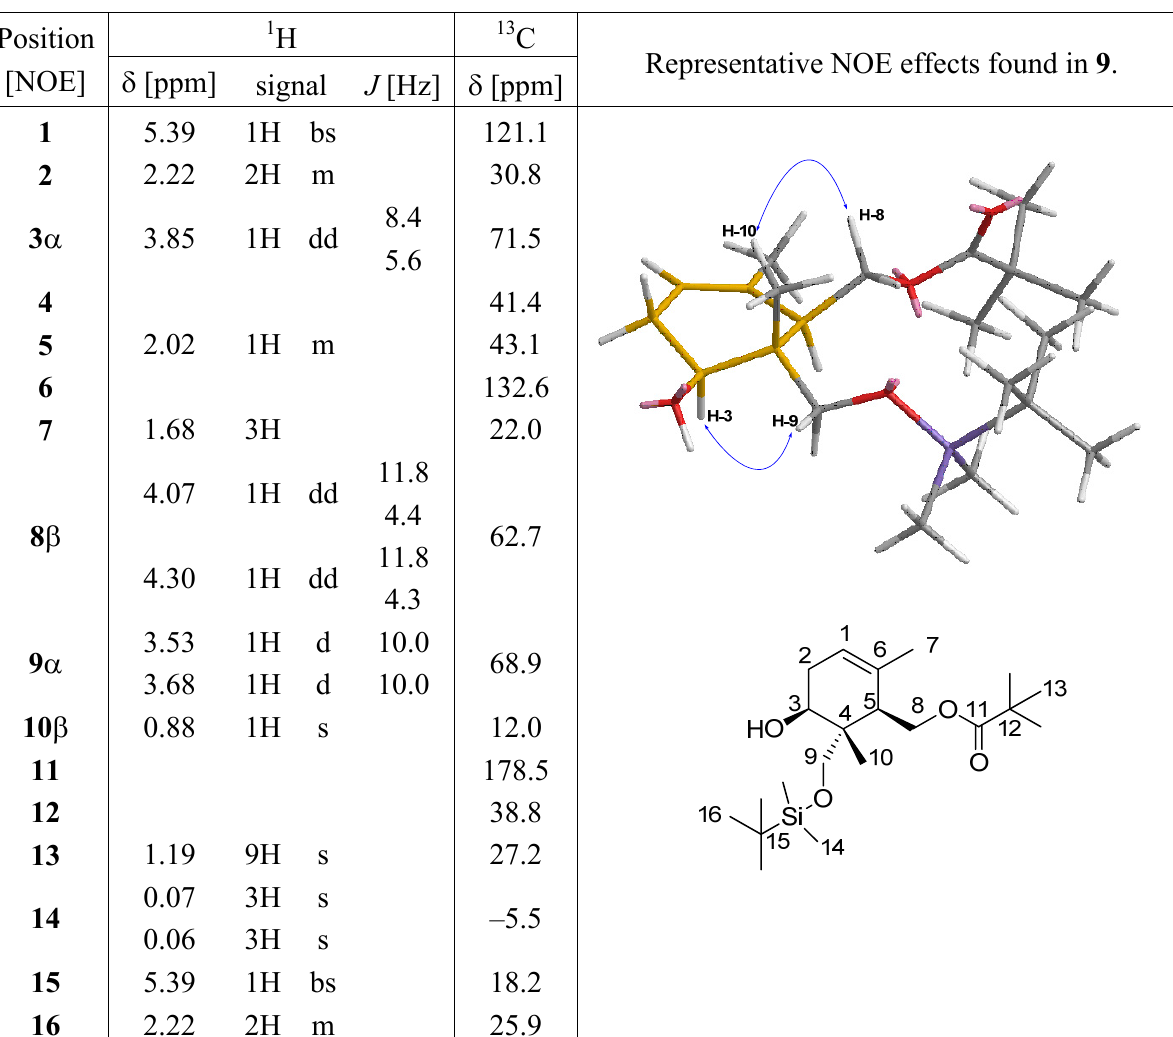
Table 2. 1 H-NMR and 13 C-NMR data for 9